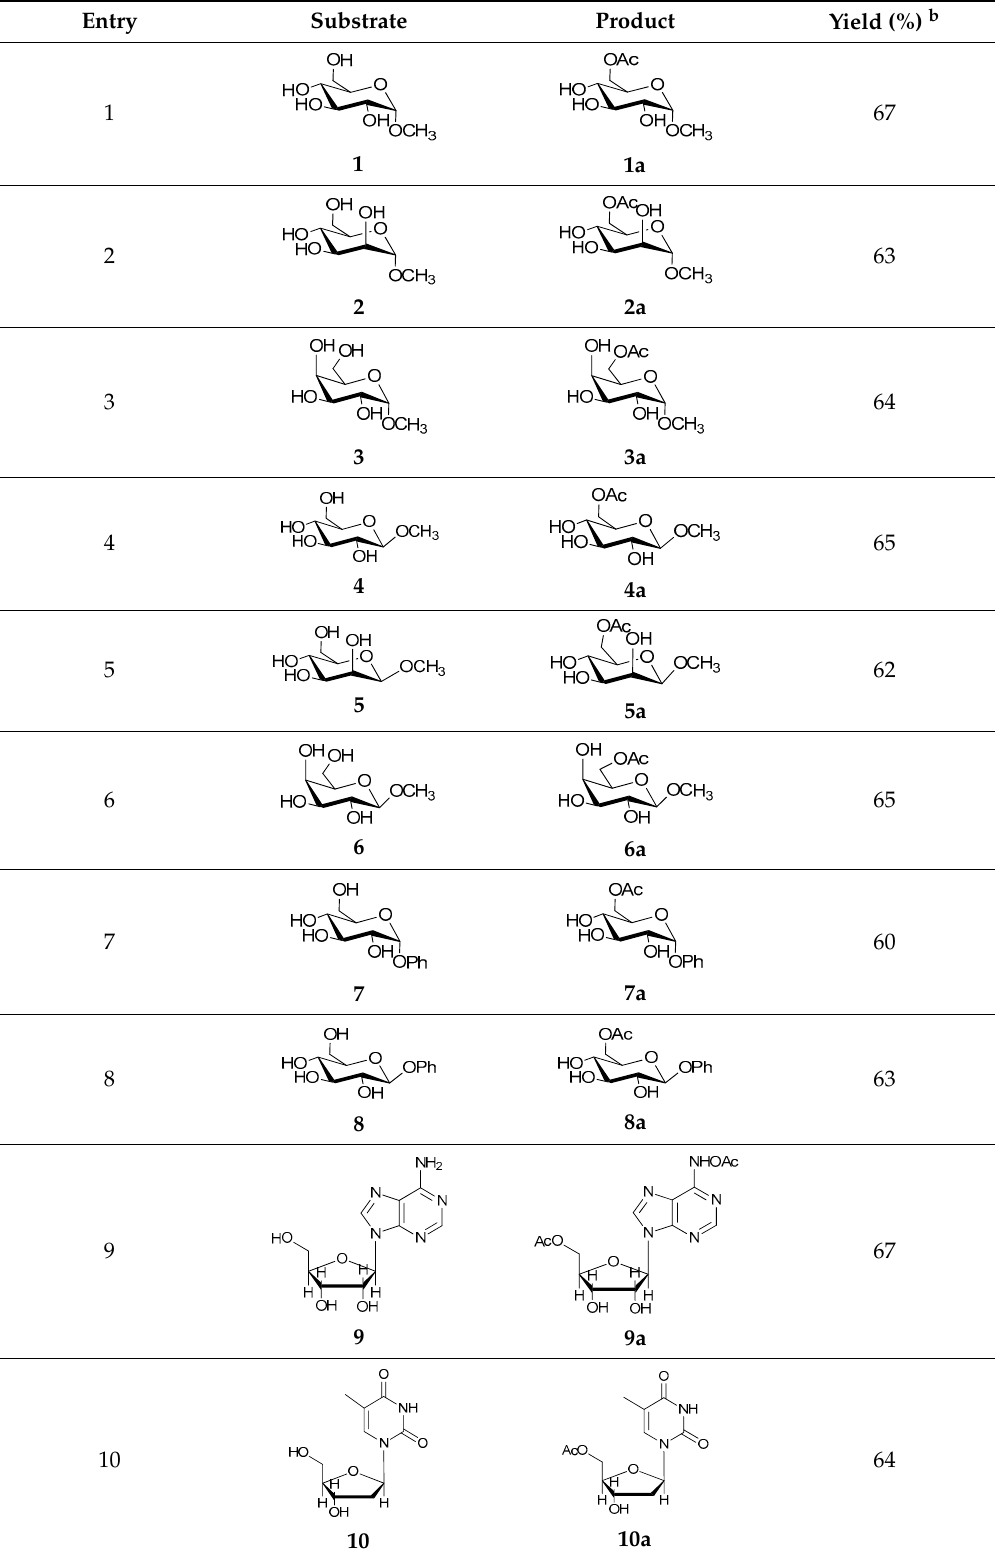
Table 2. Selective acetylation using 1 ‐ acetylimidazole in the presence of Er(OTf) 3 under MWirradiation. a